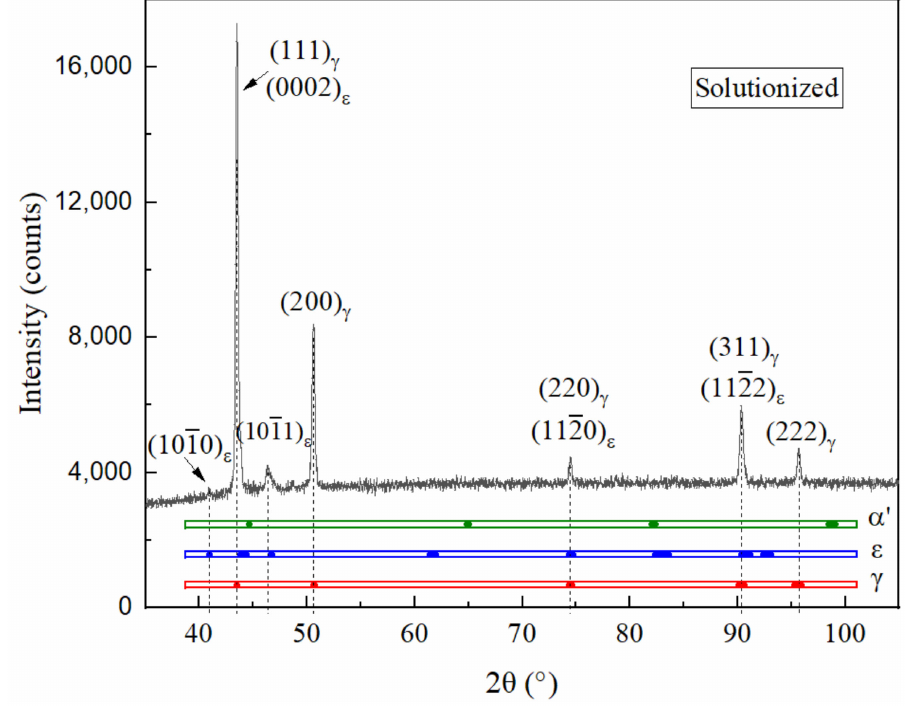
Figure 2. XRD pattern of the solutionized